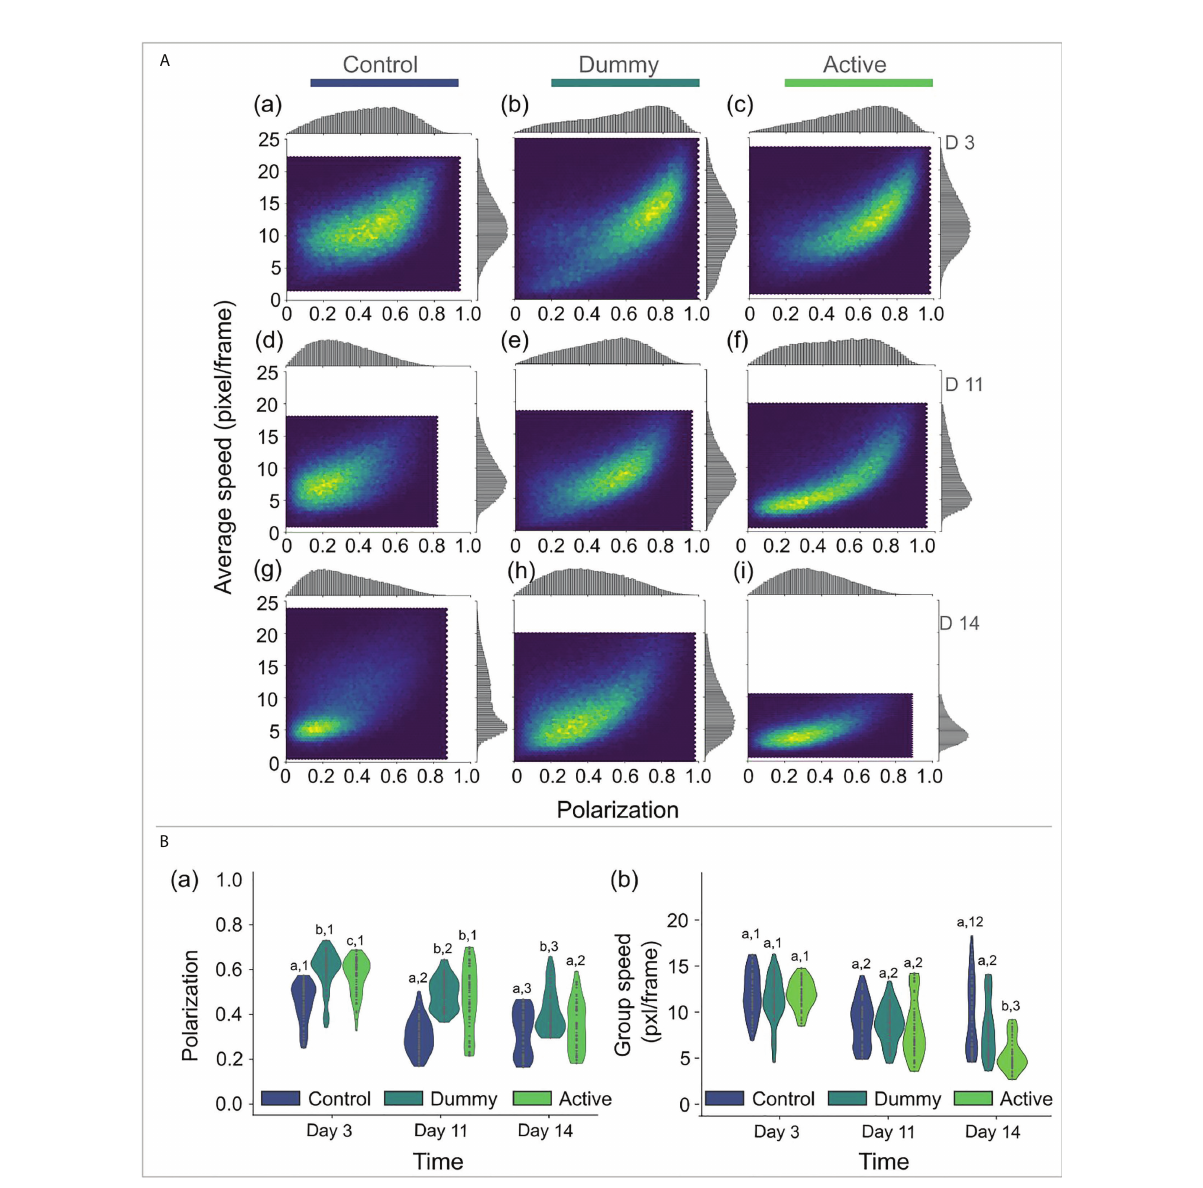
FIGURE 7 (A) Two-dimensional density plots showing the covariance of the two swimming performance variables, i.e. the average speed and the group polarization, for the different tested groups, i.e. for the control group (a, d, g), the dummy group (b, e, h), and the active group (c, f, i), and for three different days post-surgery, i.e. day 3 (a, b, c), day 11 (d, e, f), and day 14 (g, h, i). (B) Violin plots of the group polarization (a) and the group speed (b) for the different treatments (the dummy, the active group, and the control group) and for the three different days. Statistically signi fi cant differences between treatments (groups) on each sampling (day) are indicated with different letters and between samplings for each treatment with different